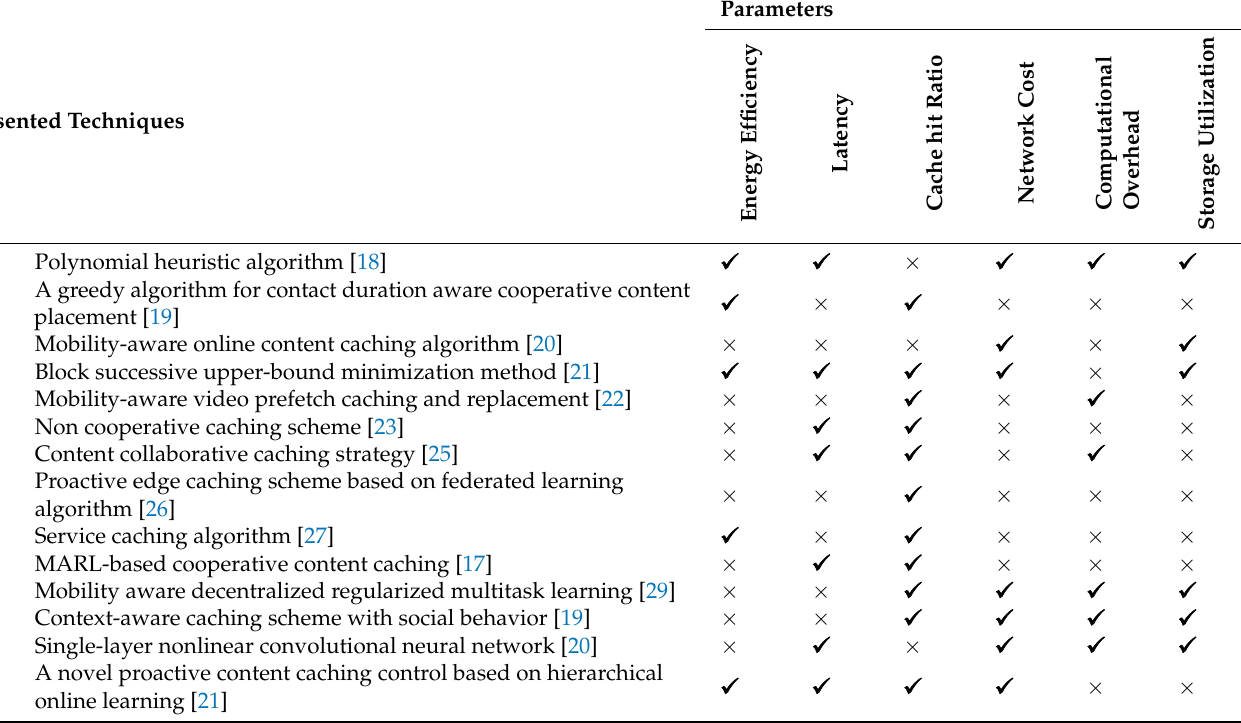
Table 1. Comparative analysis of related works.